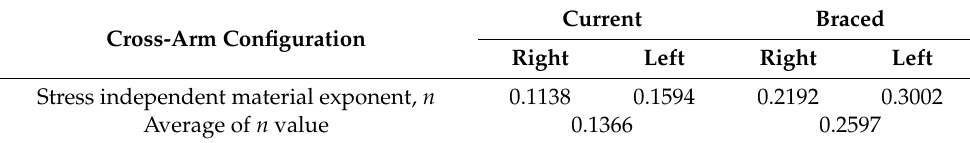
Table 2. Stress independent material exponent, n for current and braced PGFRPC cross-arms. Current Braced Cross-Arm Configuration Right Left Right Left Stress independent material exponent, n 0.1138 0.1594 0.2192 0.3002 Average of n value 0.1366 0.2597